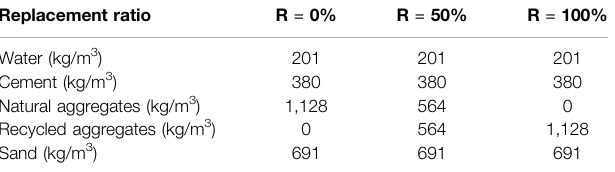
TABLE 3 | Mix proportions of RAC with different replacement ratios